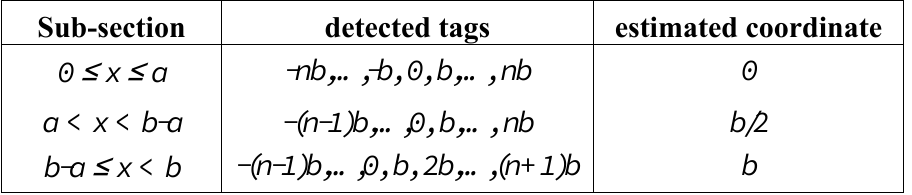
Table 1a. Estimated coordinates from analytical approach ( 0 ≤ a < b/2 ).